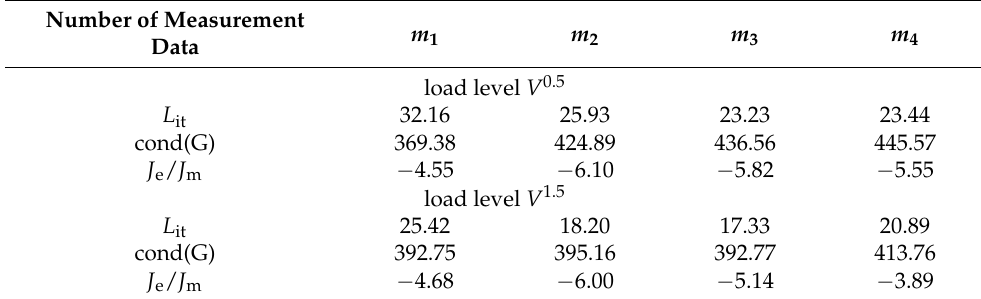
Table 7. The relative differences of mean values of the considered indices for Method 1 and Method 2 in